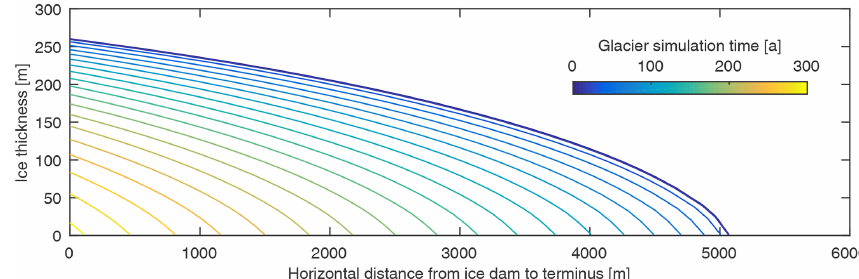
Figure 3. Ice thickness profile from the marginal basin to the terminus over 300 years of glacier